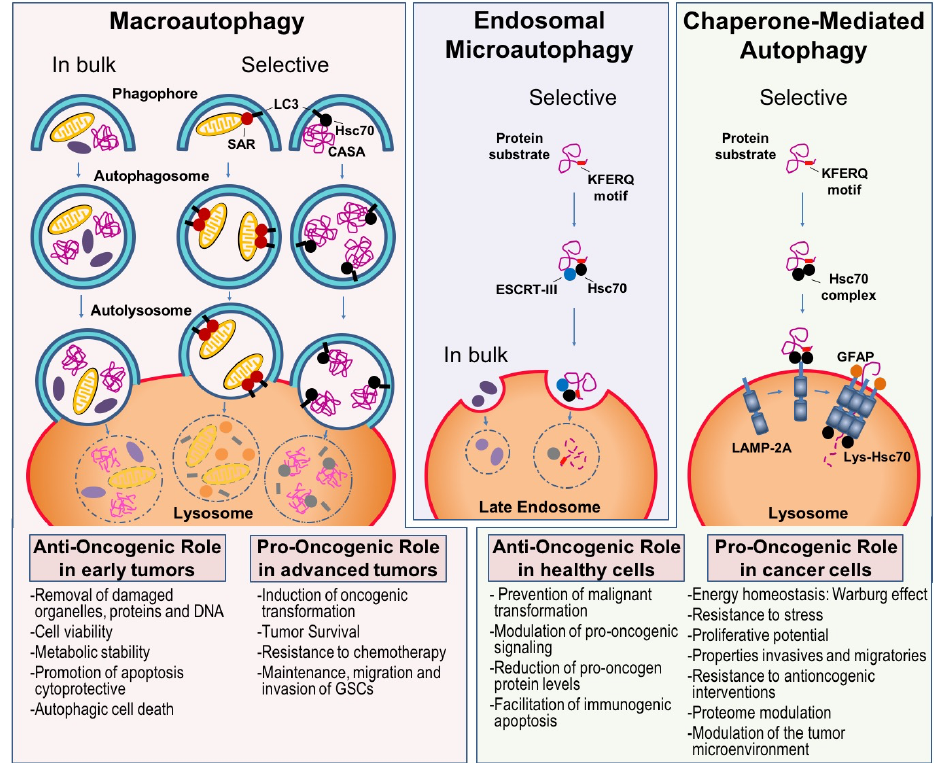
Figure 1. Types of autophagy in mammals and their anti- and pro-oncogenic roles . Macroautophagy, is a process of lysosomal degradation and recycling of cellular components, including damaged